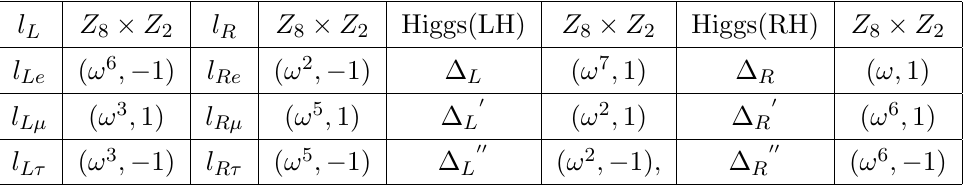
Table 1 . Particle assignments for